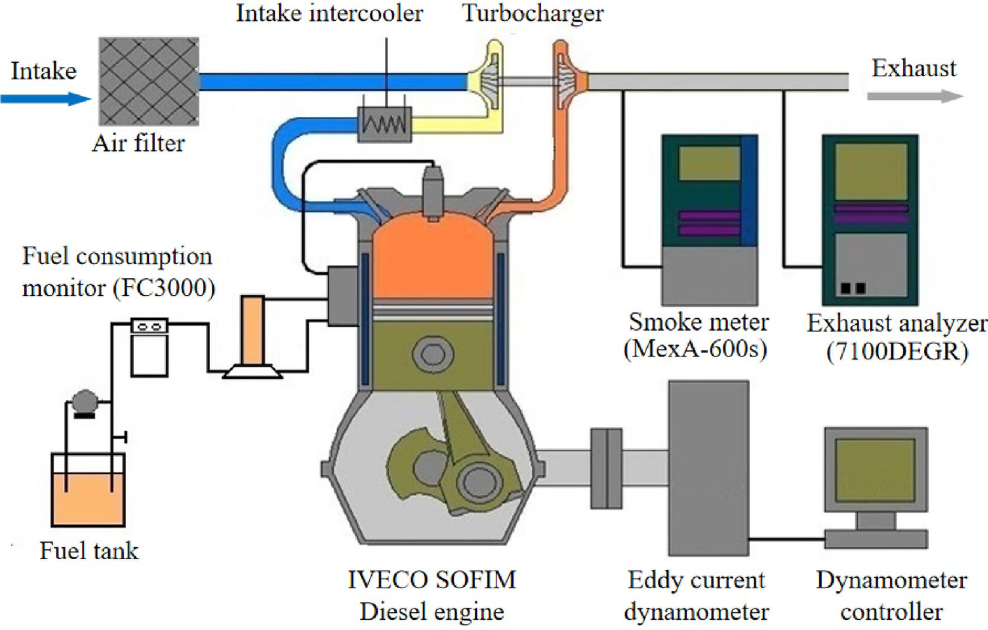
Figure 1. Schematic diagram of the testing apparatus.